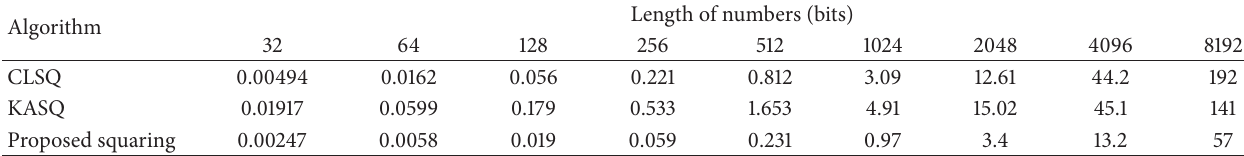
Table 5: Execution time (msec) of squaring